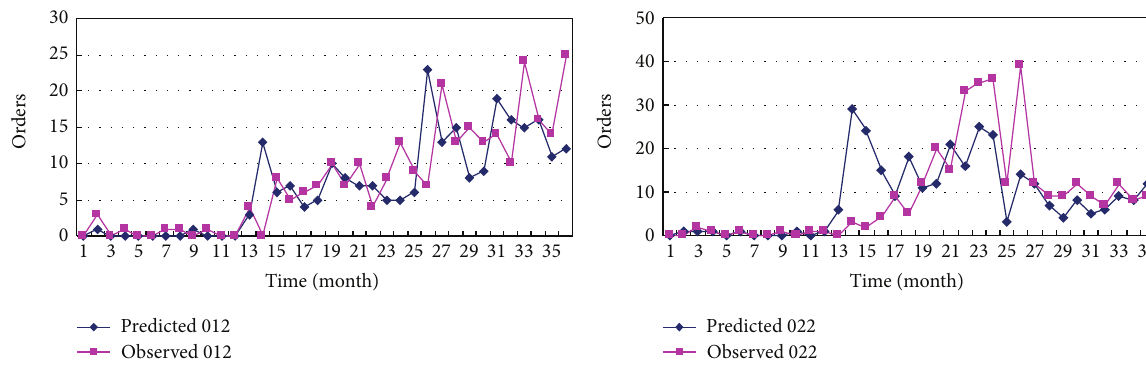
Figure 8: The orders of bulk transportation predicted by the polynomial